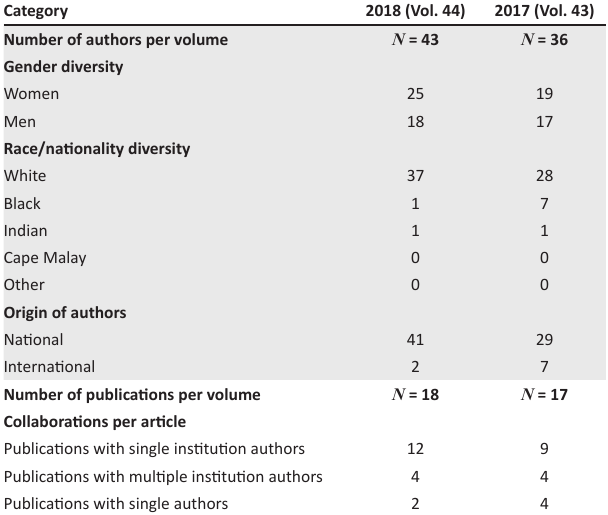
TABLE 1: Descriptive statistics for gender and race diversity, origin of authors and collaboration status in South African Journal of Industrial Psychology (2018,